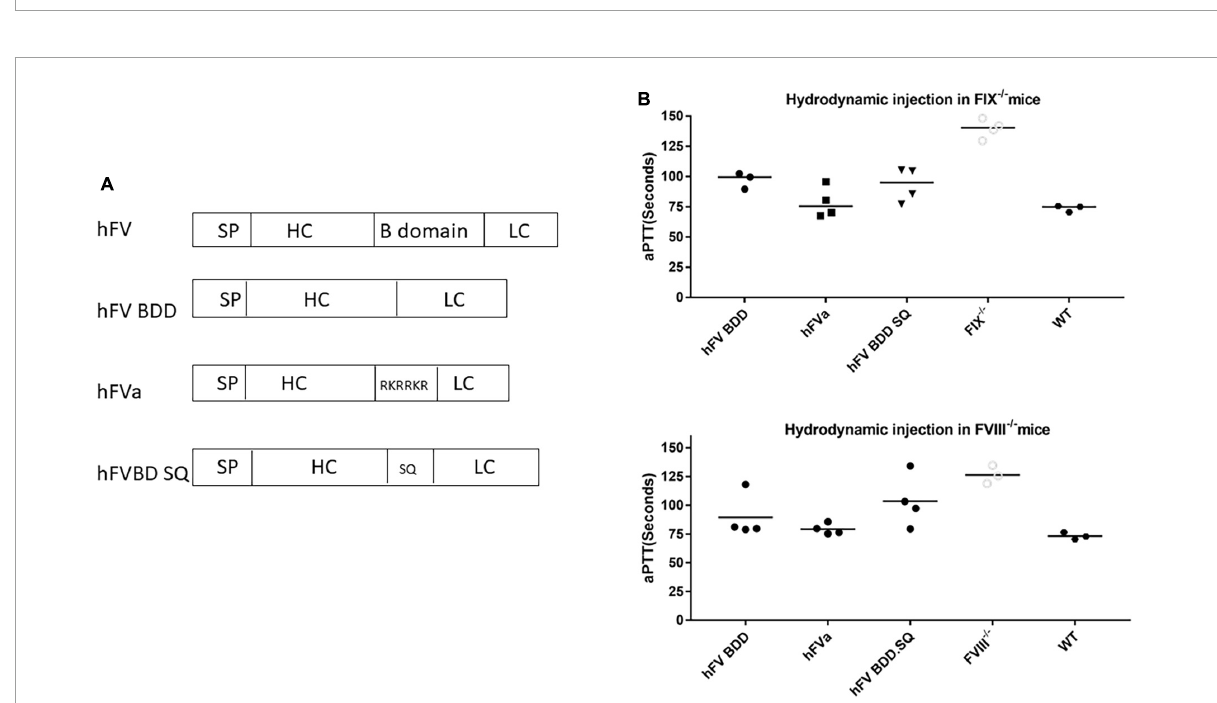
FIGURE2 FVa was functional in hemophilia mice after hydrodynamic injection of hFVa plasmids. (A) Constructs of FVa “hFV BDD”: complete deletion of B domain; “hFVa”: complete deletion of the B domain and a furin cleavage site linker between the FV heavy chain (HC) and the light chain (LC); “hFVBD SQ”: complete deletion of the B domain with an SQ sequence inserted between the HC and the LC. (B) aPTT change after hydrodynamic injection. In both FIX - / - and FVIII - / - mice, the three plasmid constructs were tested, and FVIII/FIX-specific aPTT was measured 48 h after hydrodynamic injection. FIX - / - /FVIII - / - mice (“FIX - / - ”/“FVIII - / - ”and their “WT”) controls injected with normal saline were used as the